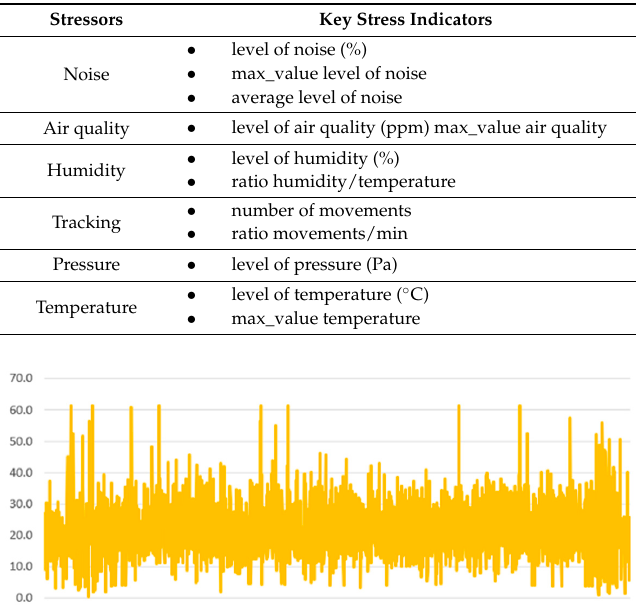
Table 1. Stressors and tested KSIs.